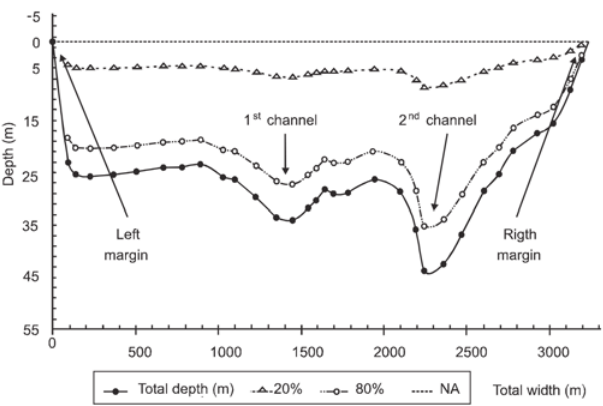
Fig. 3. Transverse profile obtained from the Solimões River using Winriver software. (NA = water level, 20% and 80% of the depth). Fig. 4. Ordination of the samples (canal and season) of the hydrological cycle, where: J = Jacaré lake canal, C = Cururu lake canal, 1 = rising waters, 2 = flood, 3 = receding waters, and 4 = drought.